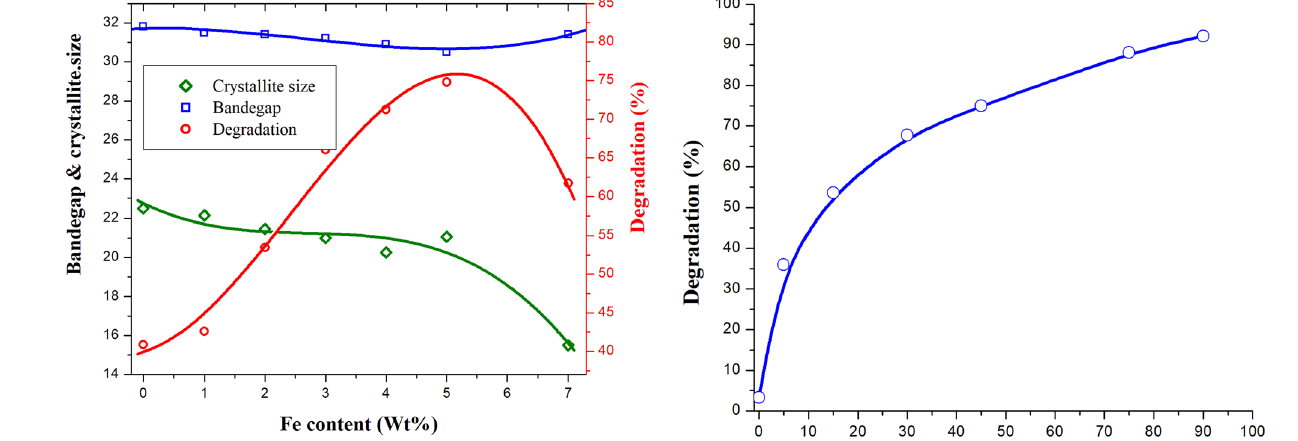
Figure 10 represents the e ff ect of irradiation time on MO degradation over the best photocatalyst of the series,